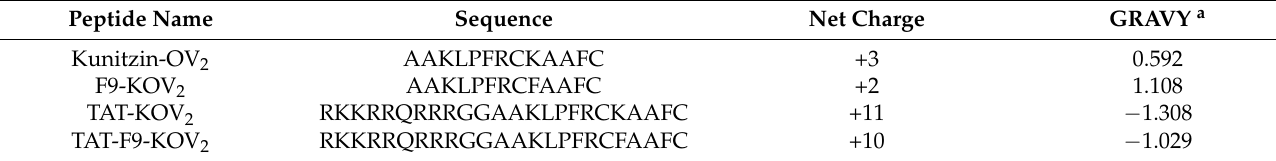
Table 1. The sequences and physicochemical properties of kunitzin-OV 2 and its rational